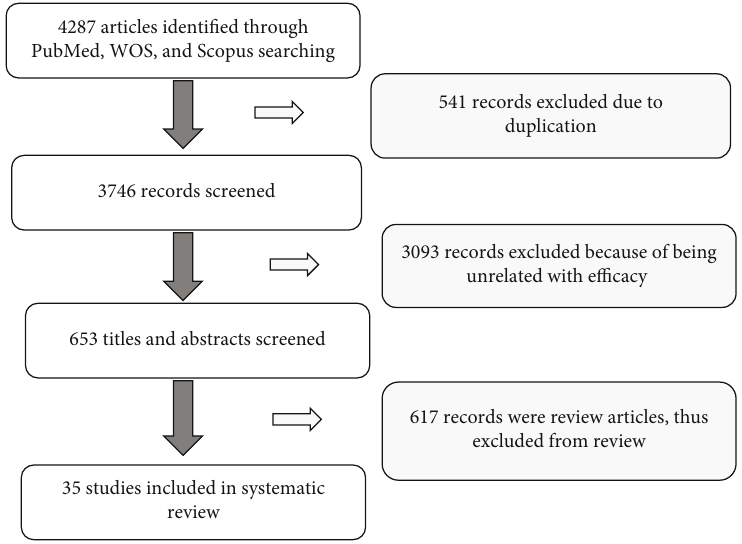
Figure 1: Literature search and study selection fl